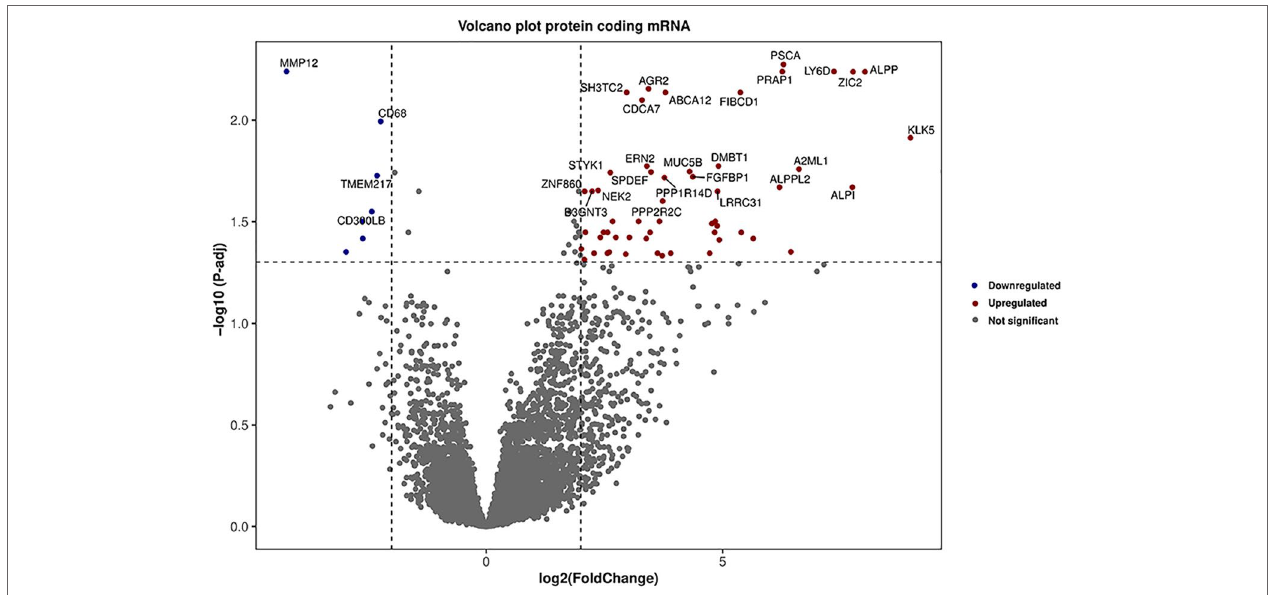
FIGURE 2 | Volcano plot for the differentially expressed genes. Genes which are in red and blue colors are highly upregulated and downregulated, respectively in PDAC. Vertical and horizontal dot line represents a cutoff point for log fold-change p -value respectively.